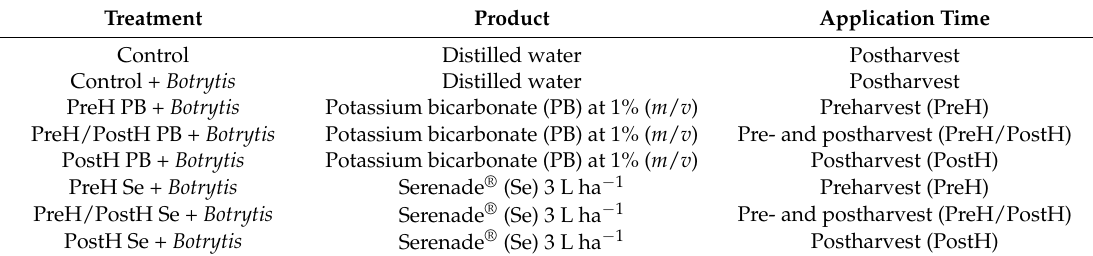
Table 1. Treatments applied at pre- and postharvest on ‘BRS Isis’ seedless table grapes. Treatment Product Application Time Control Distilled water Postharvest Distilled